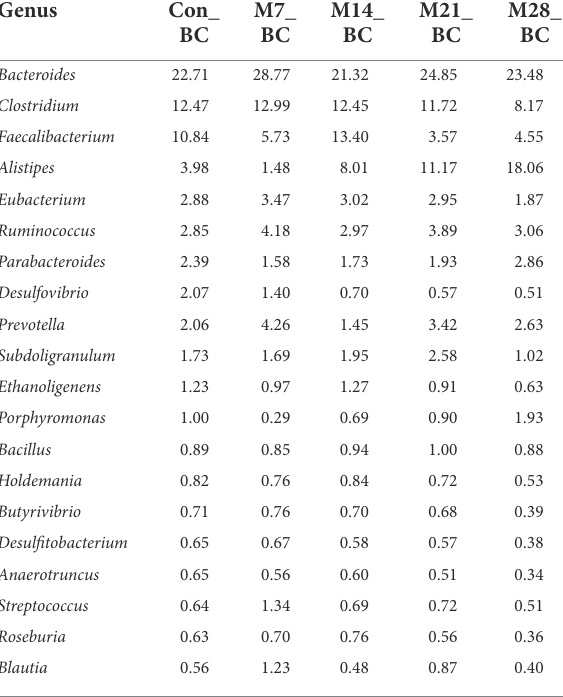
TABLE 2 Relative abundance (%) of the dominant genera (top 20) in caecum digesta samples from broiler chickens fed with diets containing different levels of marama bean